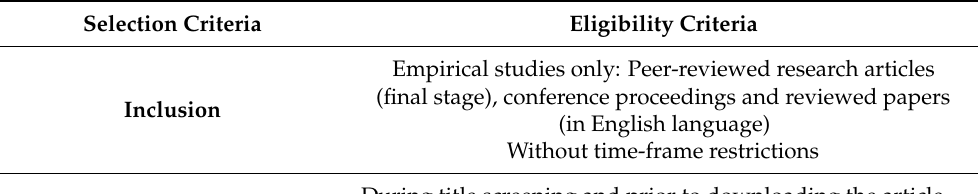
Table 2. Inclusion and exclusion criteria.